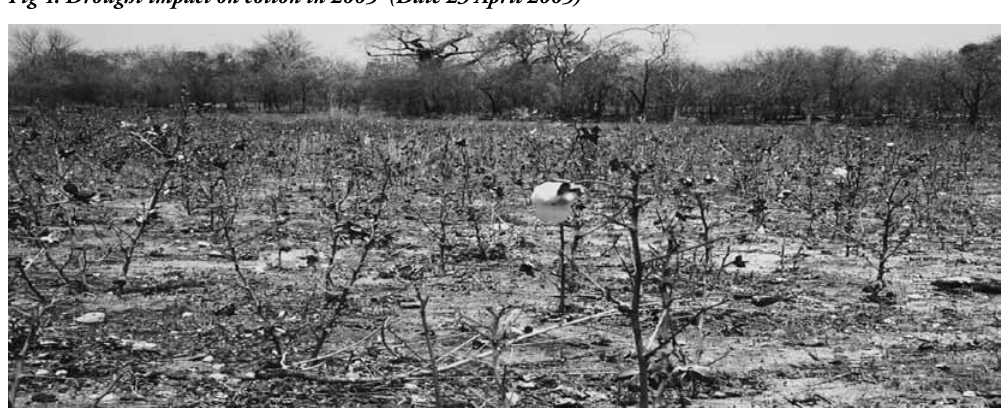
Fig 4. Drought impact on cotton in 2005 (Date 23 April 2005)